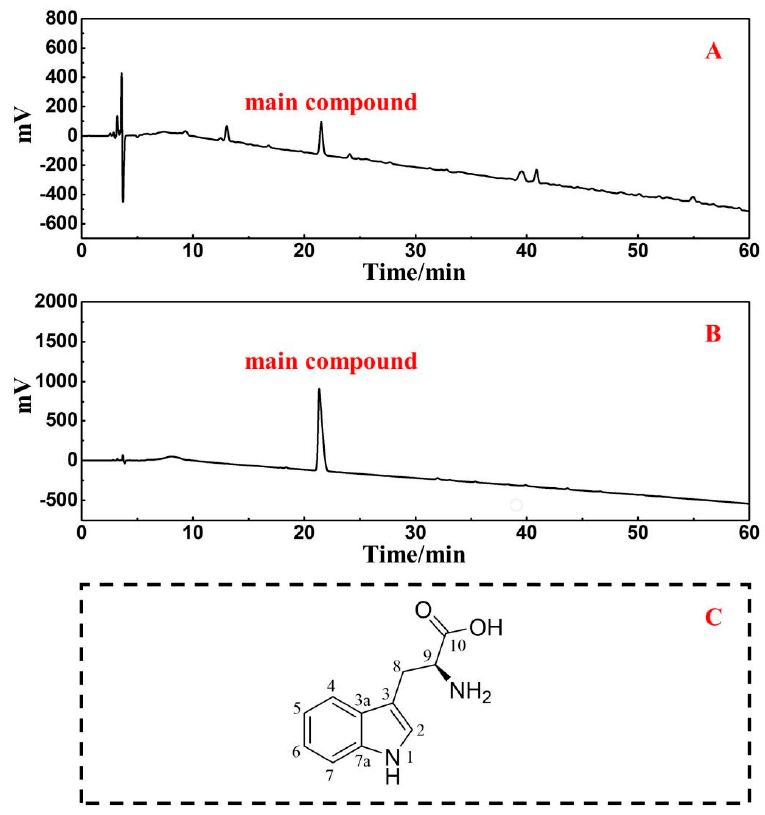
Figure 4. ( A ) The analytical chromatogram of fraction of crude Medicago sativa sample on the ReproSil-Pur C18 AQ analytical column. ( B ) The analytical chromatogram of fraction Fr341 on the ReproSil-Pur C18 AQ analytical column. ( C ) Structural formula of L-tryptophan.